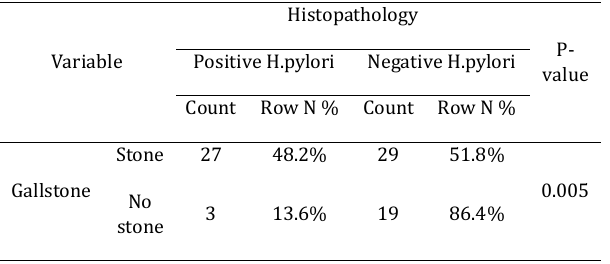
Association between Histopathology diagnosis and H.pylori infection (Acalculus &